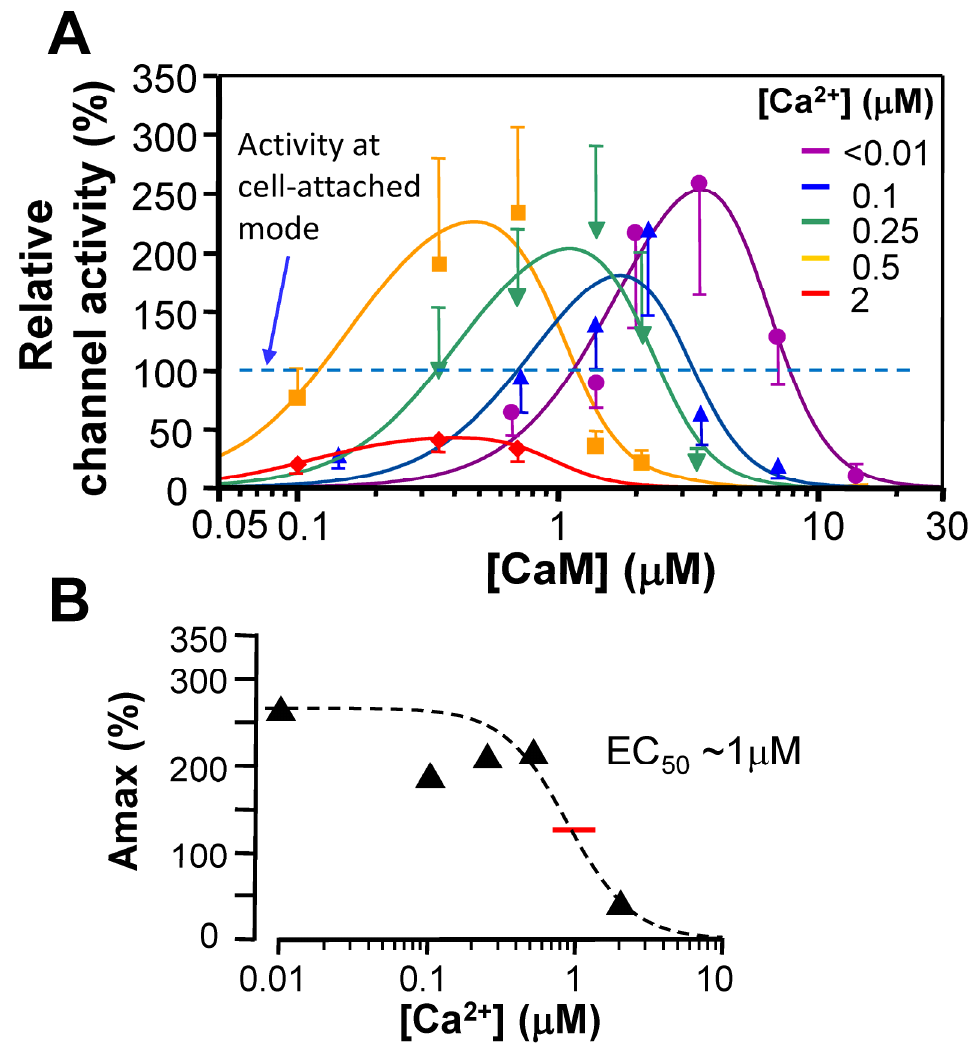
Figure 2. Effect of CaM in cell-free patches of cardiomyocytes. ( A ) Concentration-dependent effect of CaM on activity of Cav1.2 channels recorded in inside-out patches of guinea-pig cardiomyocytes at fixed [Ca 2+ ], as indicated by colors on the right side of the graph. Channel activity was normalized to that recorded in the preceding cell-attached mode. Date are represented as the mean ± S.E.M. (n = 6–11) with regression curves with an equation as Amax · ([CaM]/Kd f ) nf / {1+([CaM]/Kd f ) nf } · 1/{1+([CaM]/Kd i ) ni }, where Amax is maximum channel activity, [CaM] is concentration of CaM, Kd f and Kd i are CaM’s dissociation constant for facilitation and inactivation, respectively, and n f and n i are the Hill’s coefficients for facilitation and inactivation, respectively. ( B ) Relationship between estimated maximum activity (Amax) and [Ca 2+ ]. Data were fitted with Hill’s curve with EC 50 ~1 µ M (red bar). Reproduced from Han et al. [51] with